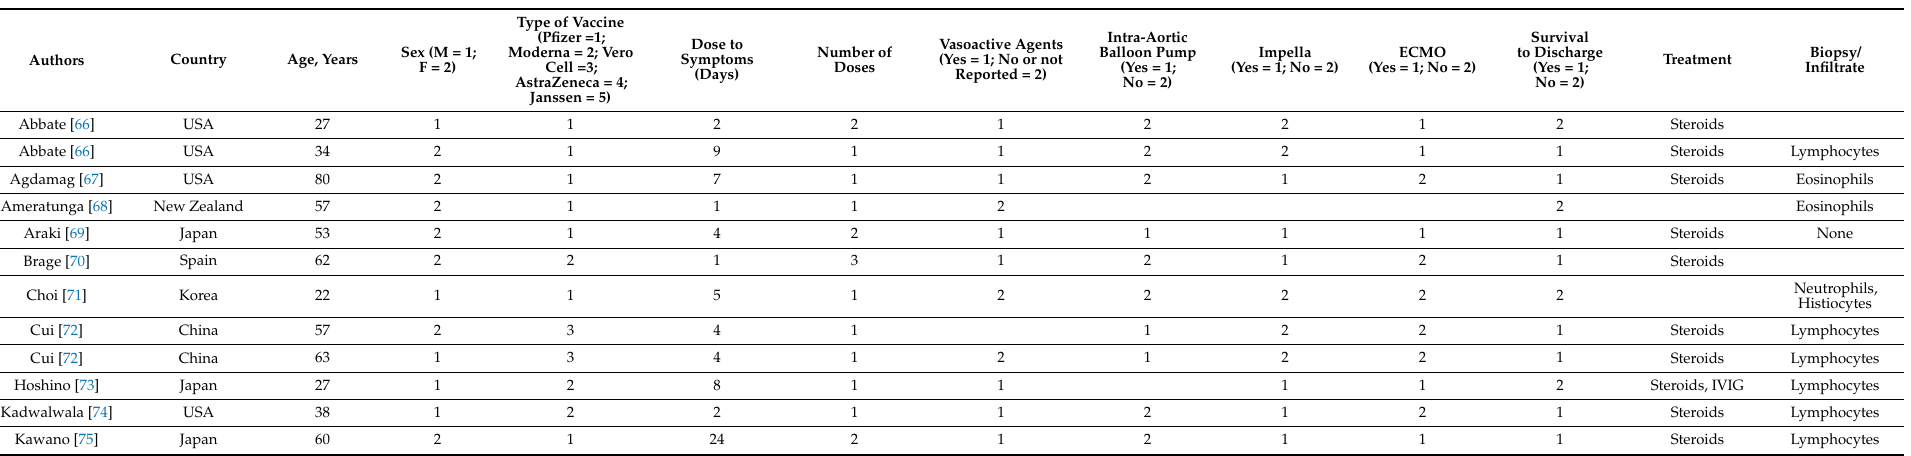
Table 2. Cases of COVID-19 vaccine fulminant